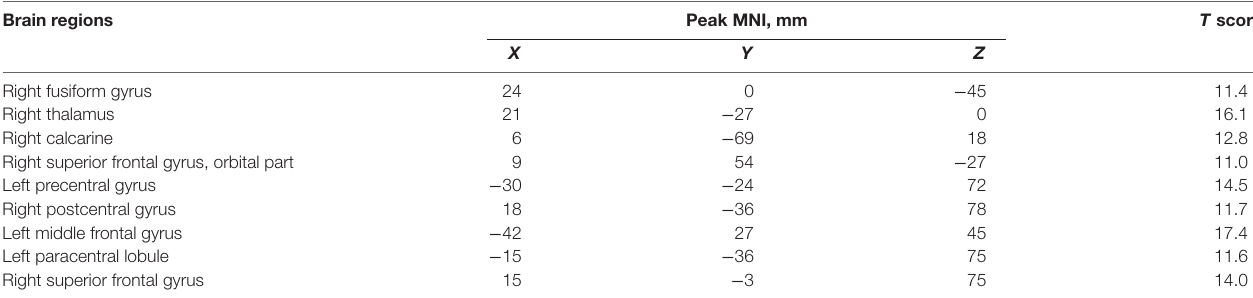
TABLE 2 | A one-way analysis of variance result of the regional homogeneity differences among healthy controls and patients with and without MHE. Brain